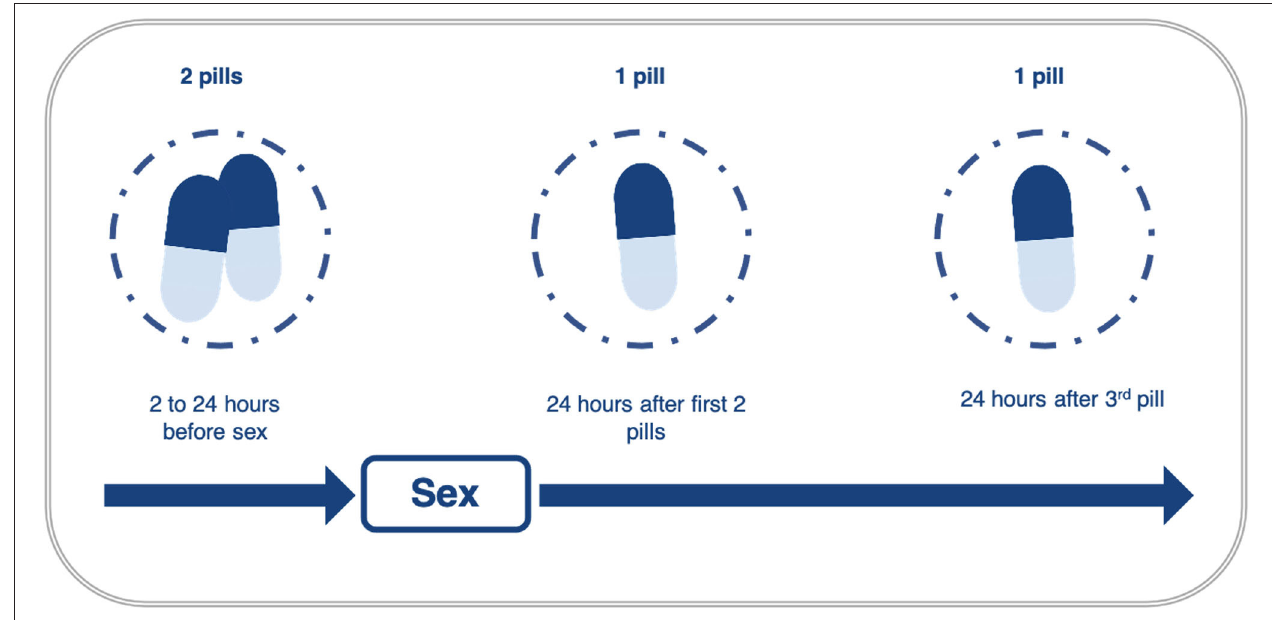
FIGURE 2 | Schematic representation of the ED-PrEP 2 + 1 + 1 regimen, adapted from the update to WHO’s recommendation on oral PrEP in 2019 (42).